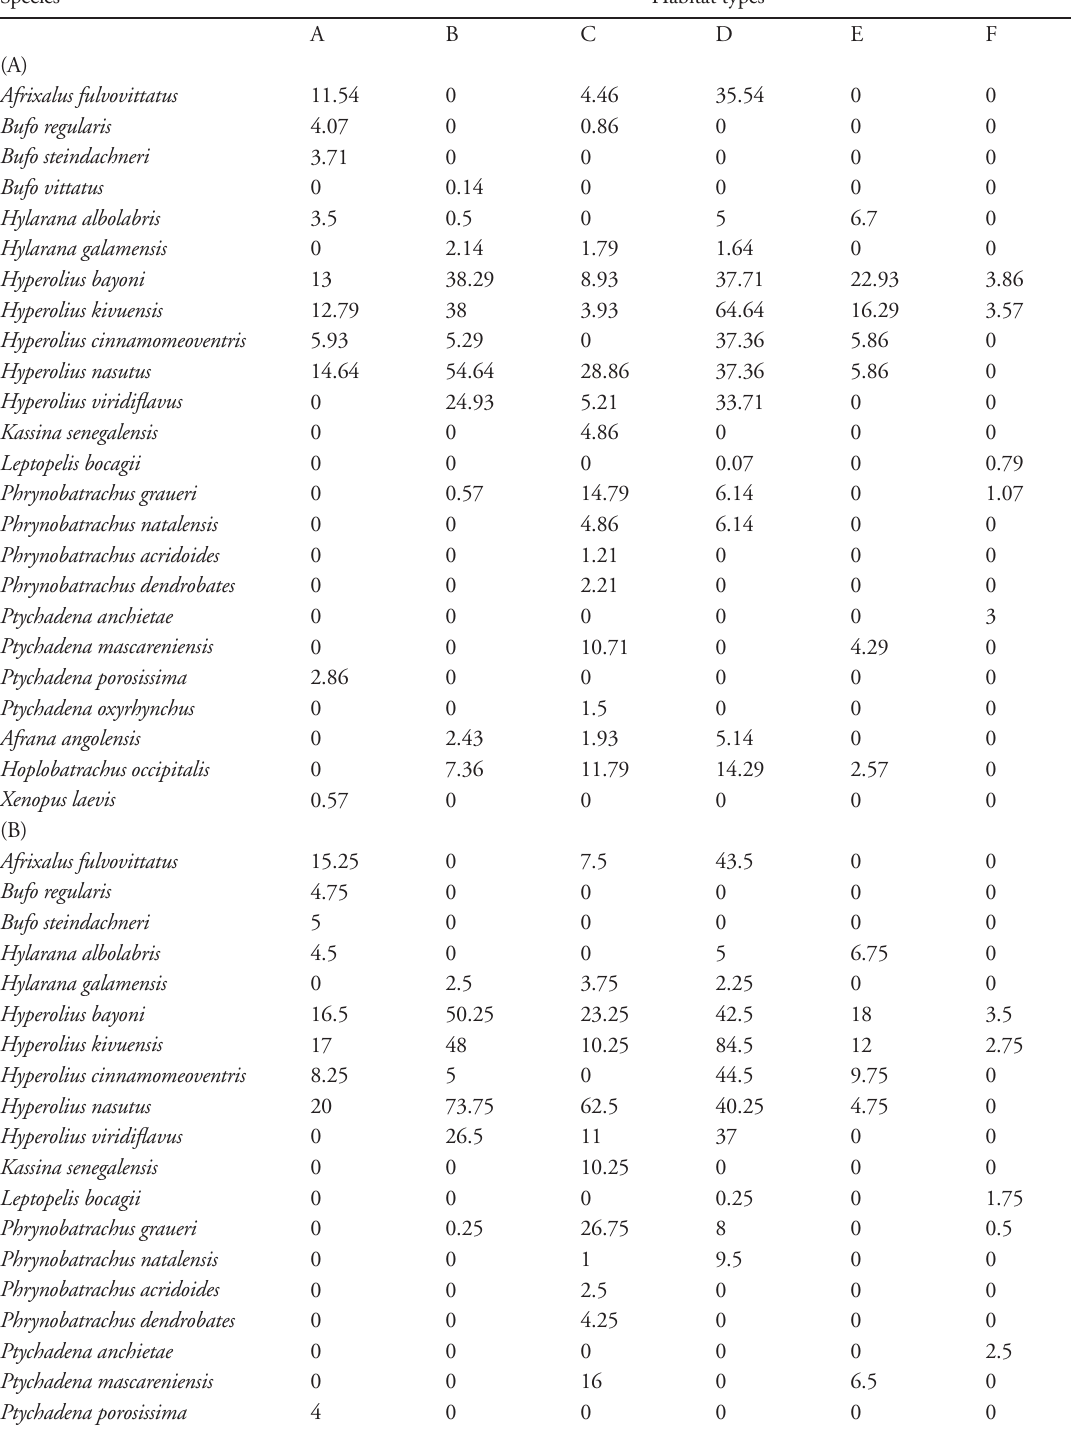
Table 1. Relative abundance of the amphibian species at the study area, by habitat type. Data are presented with wet and dry seasons cumulated (A), only wet season (B), and only dry season (C). Species Habitat